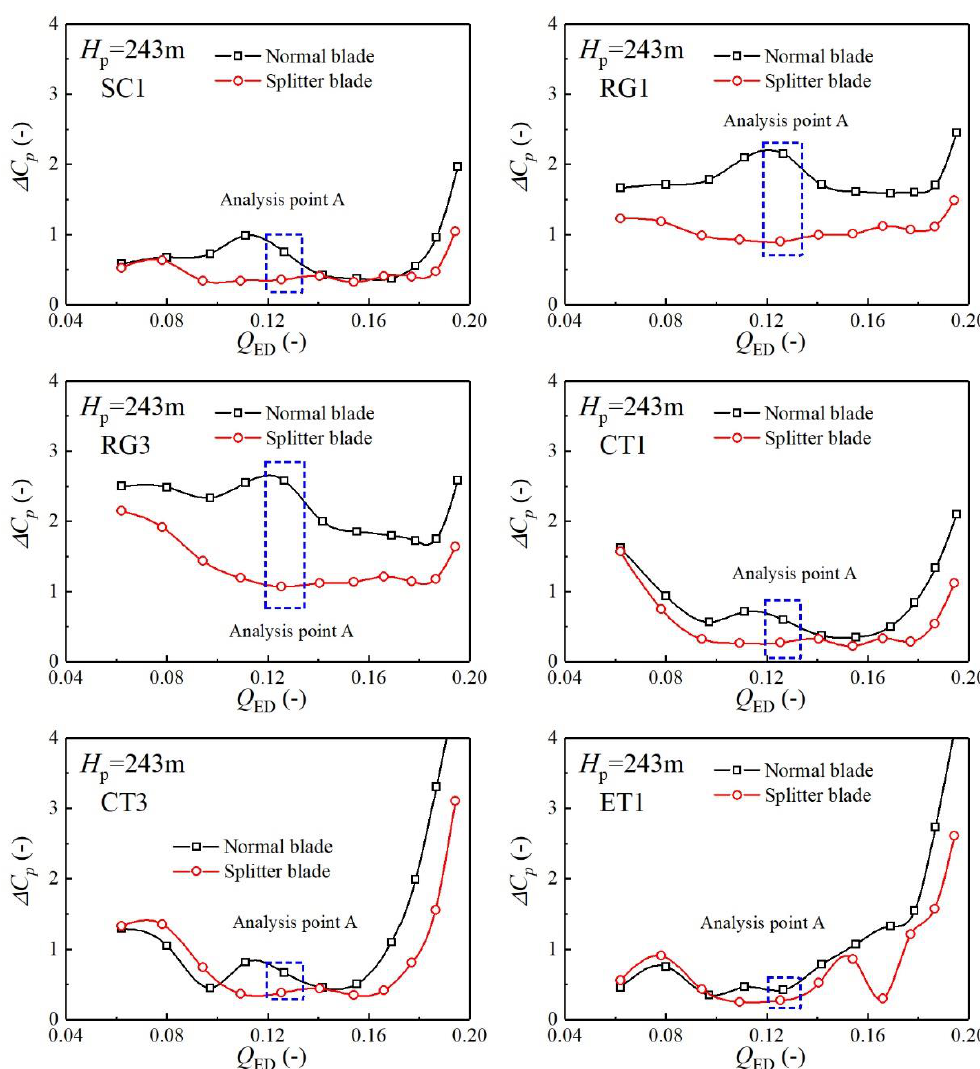
ff erent positions at H